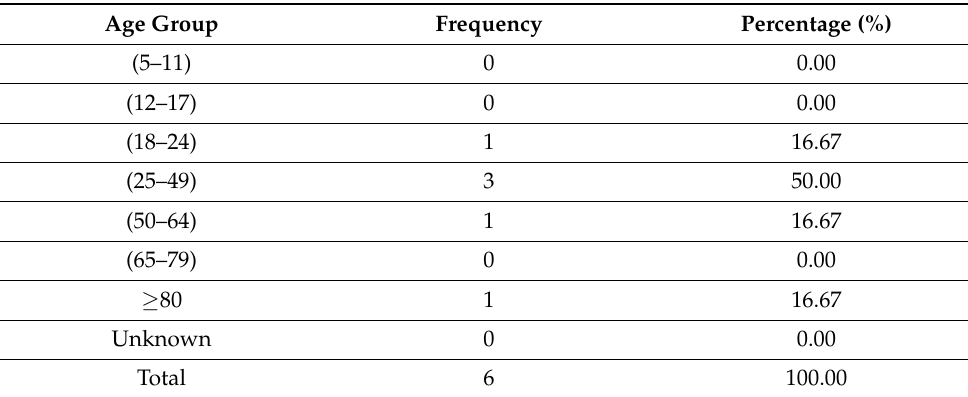
Table 6. Characterization of serious notifications with the seriousness criterion “Life Risk”, according to the associated